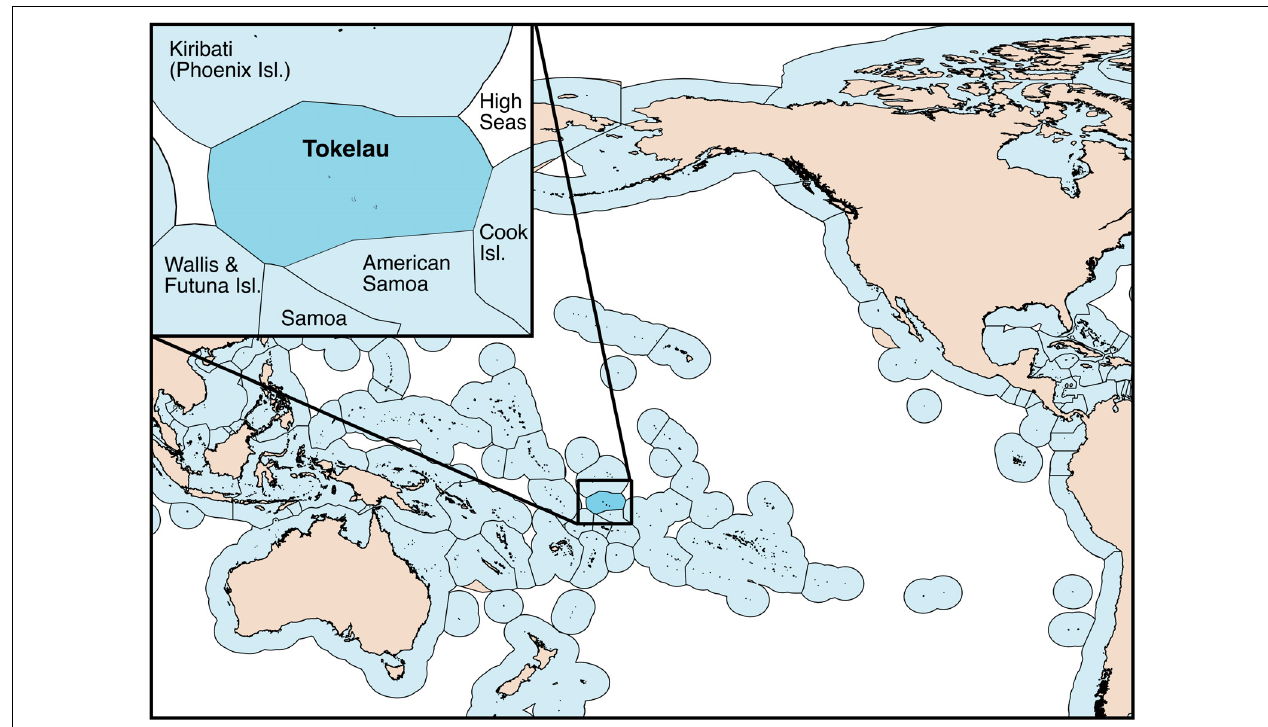
FIGURE 1 | The Exclusive Economic Zone (EEZ) of Tokelau, an overseas territory of New Zealand, and the neighboring EEZs of Kiribati (Phoenix Islands), Wallis and Futuna Islands (French overseas territory), Samoa, American Samoa (United States overseas territory), and the Cook